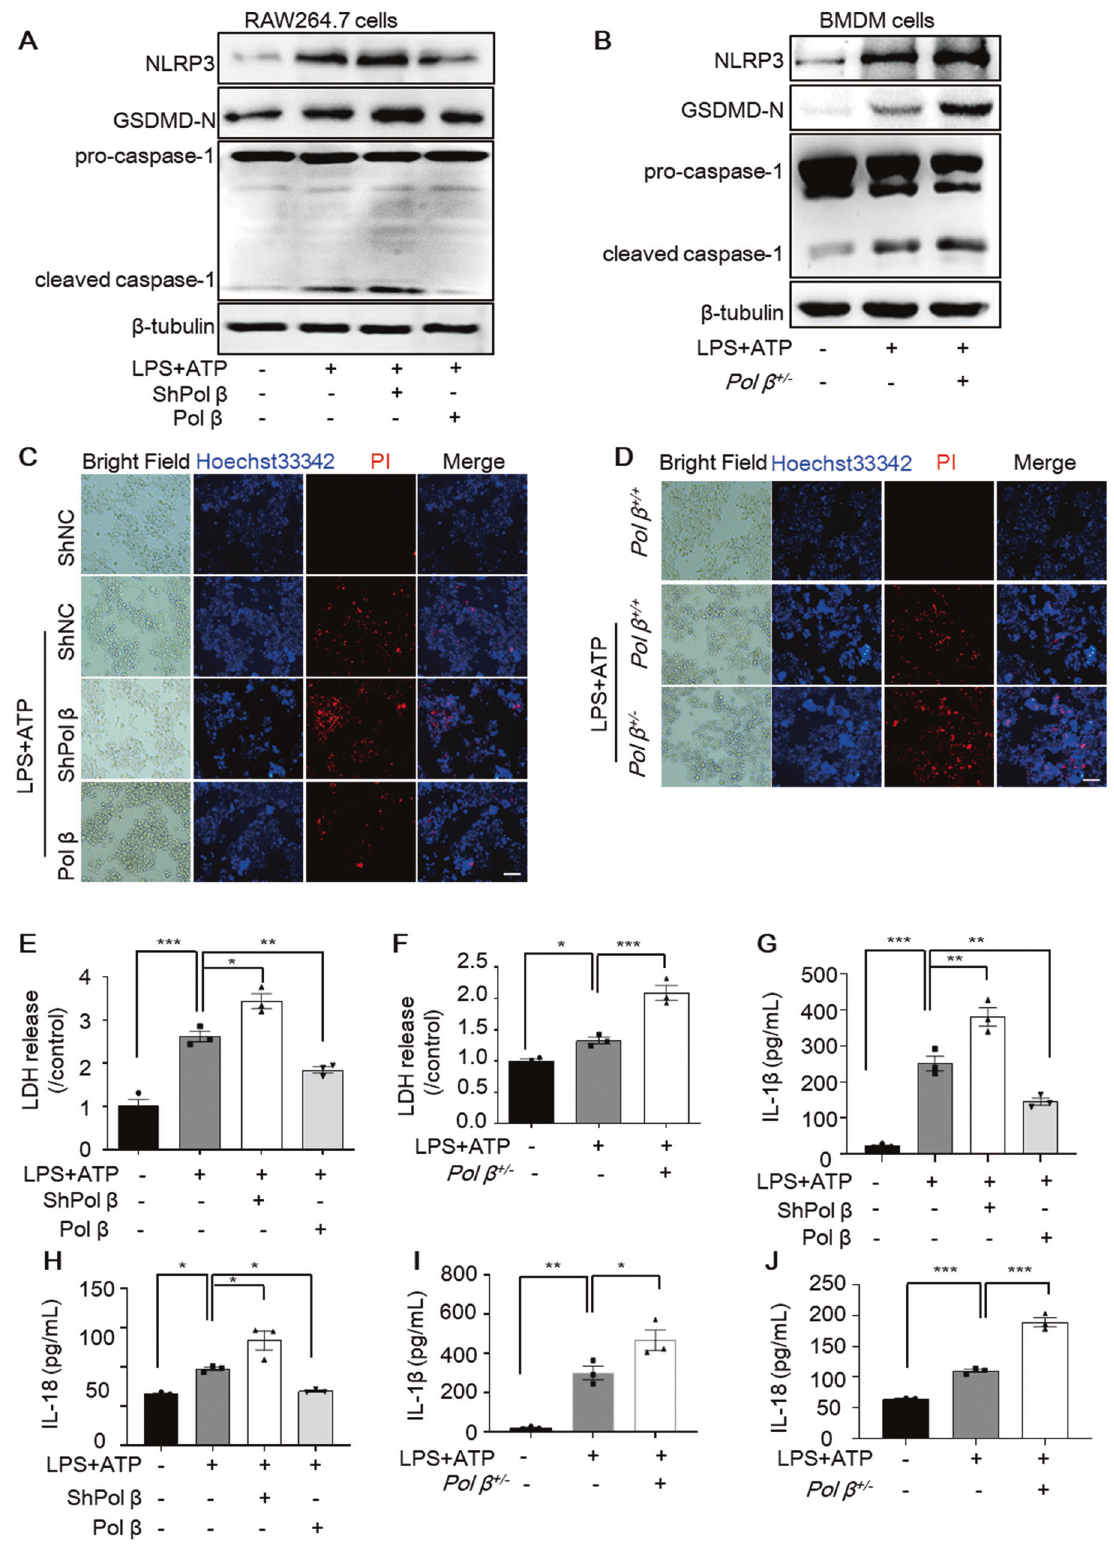
Fig. 3 Pol β regulates pyroptosis in macrophages. A , B RAW264.7 cells with stable knockdown or overexpression of Pol β or BMDMs from Pol β + / − mice were treated with 1 μ g/mL LPS for 4 h, and 5 mM ATP was then added and incubated for an additional 1 h, and the levels of NLRP3, GSDMD-N, and caspase-1 expression were determined by Western blotting. C , D Representative images of Hoechst 33342 and PI double fl uorescent staining. Scale bar, 50 μ m. E , F LDH release levels in RAW264.7 cells after pyroptosis induction. Data present mean ± SEM of three independent experiments. * P < 0.05, ** P < 0.01, *** P < 0.001, one-way ANOVA. ELISA analysis of IL - 1 β and IL-18 secreted by RAW264.7 cells with stable knockdown or overexpression of Pol β ( G , H ) or BMDMs from Pol β + / − mice ( I , J ) after LPS plus ATP treatment. Data present mean ± SEM of three independent experiments * P < 0.05, ** P < 0.01, *** P < 0.001, one-way ANOVA. Cell Death and Disease (2022)